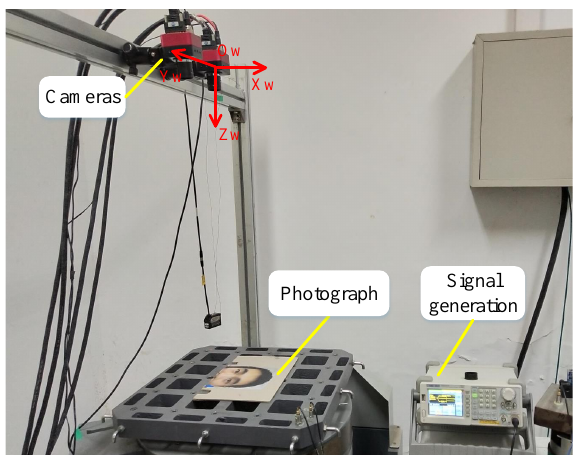
Figure 7. Experimental setup for dynamic calibration (movement in the Z